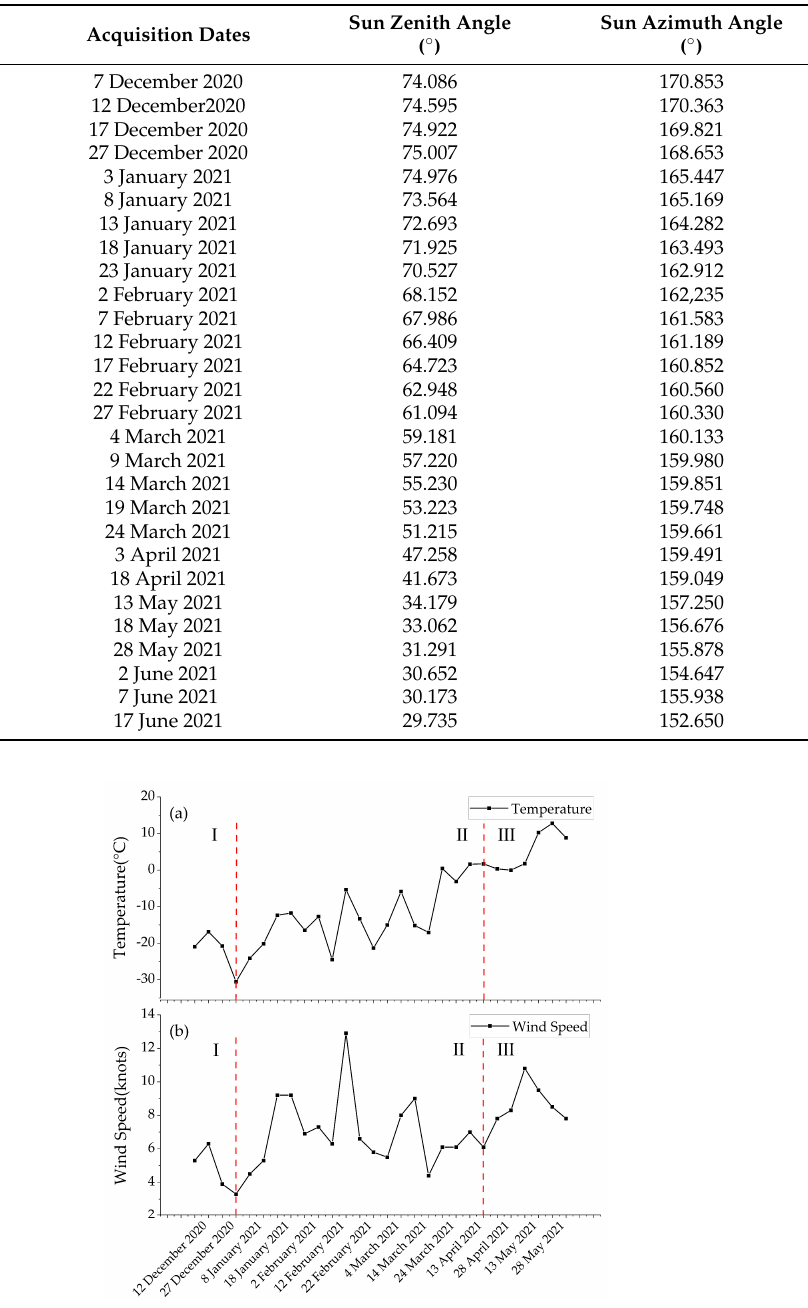
Table 1. The Sentinl-2 optical images used in this paper.